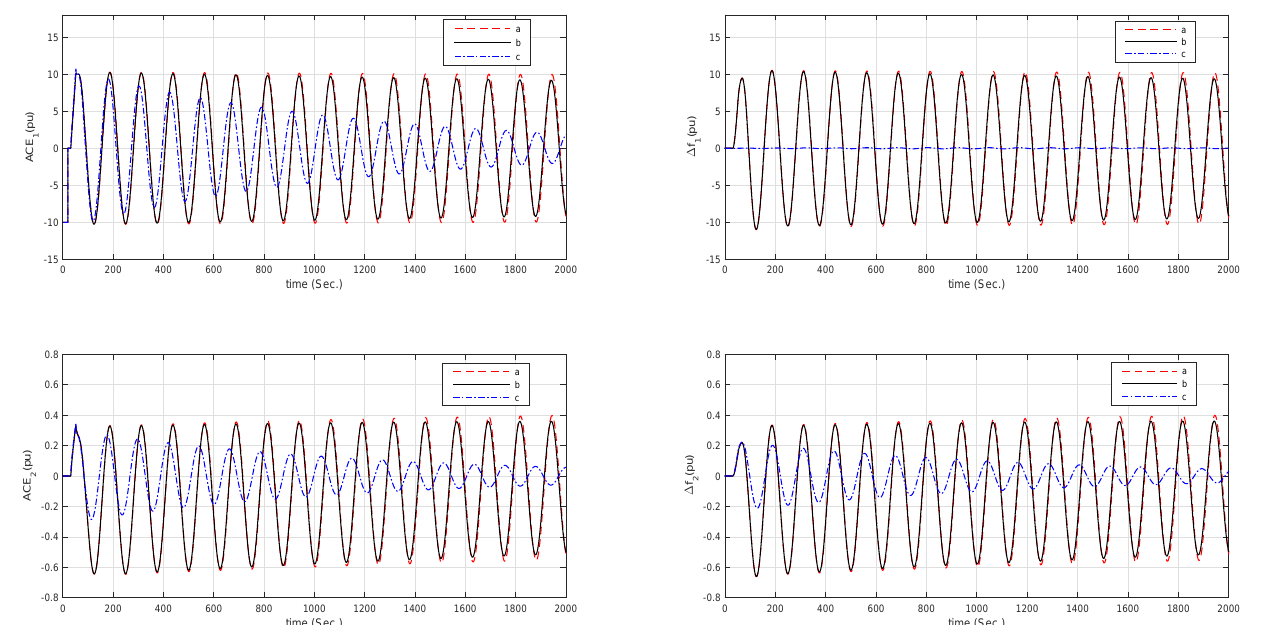
Figure 8. Frequency deviation and control error responses of two-area deregulated LFC scheme with K I = 0.05, h 1 ( t ) = 0 and different K P , h 2 ( t ) .